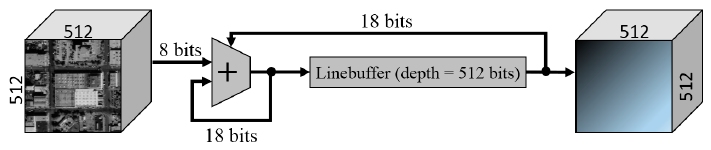
Figure 5. FPGA implementation of integral image.